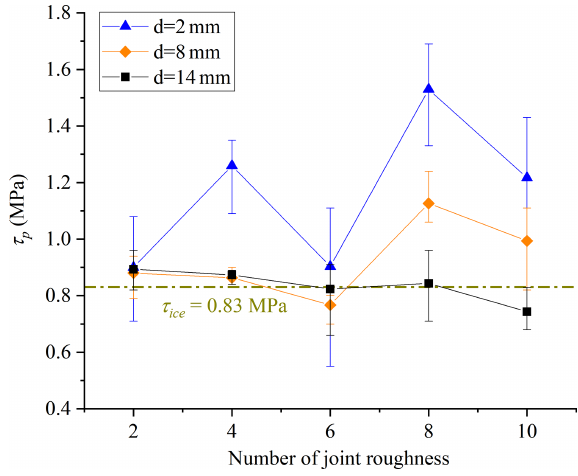
Figure 14. Effect of joint opening on the peak shear strength. Experimental conditions: T =− 5 ◦ C, v = 0.2mmmin − 1 and σ n =